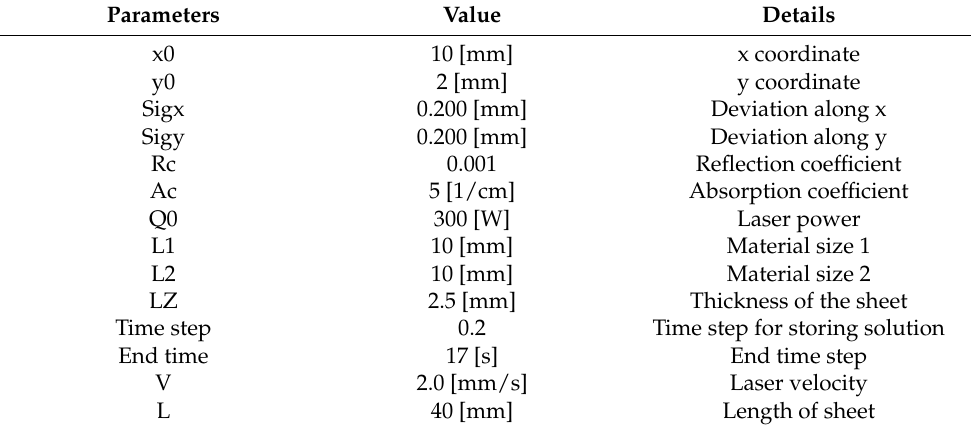
Table 1. Global parameters.